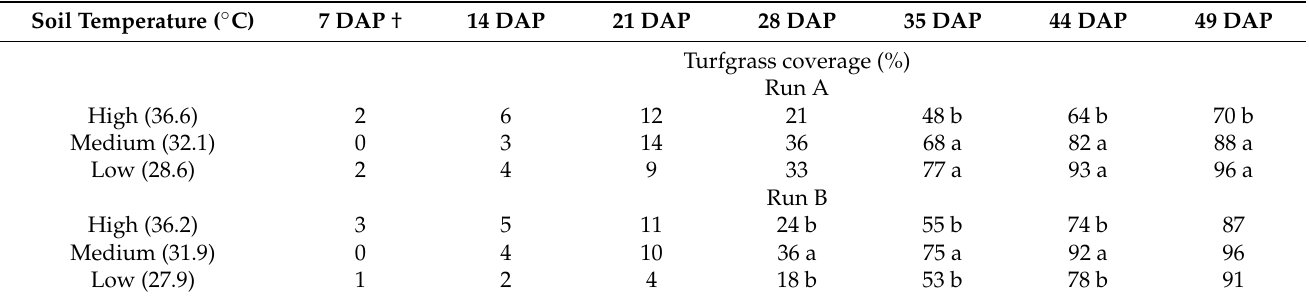
Table 1. Analysis of variance testing the main effects and their interactions on turfgrass coverage during experimental run A and B. Source of Variation Run A Run B P > F Turfgrass coverage Soil temperature 0.16 0.08 Days after planting (DAP) <0.0001 <0.0001 DAP × Soil temperature <0.0001 0.0006 Note. Bolded p values indicate significant higher-order treatment interactions. Table 2. Turfgrass coverage of ‘Prizm’ zoysiagrass ( Zoysia matrella (L.) Merr.) established in glasshouses in Knoxville, TN. Treatments included high, medium, and low 5 cm soil tempera- tures, which averaged 36.6 ◦ C, 32.1 ◦ C, and 28.6 ◦ C in run A and 36.2 ◦ C, 31.9 ◦ C, and 27.9 ◦ C in run B. Within evaluation dates, means followed by the same letter are not significantly different according to Fisher’s protected LSD ( p ≤